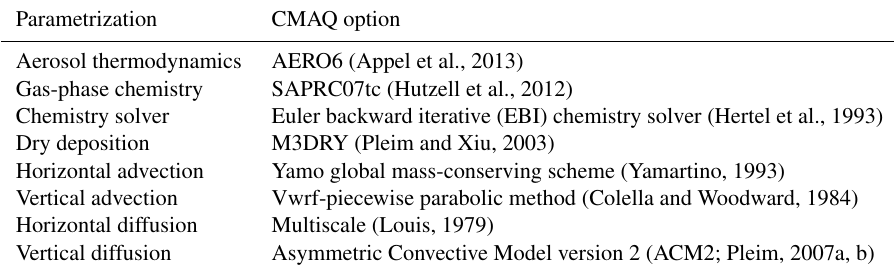
Table 2. CMAQ model configurations selected in this study.